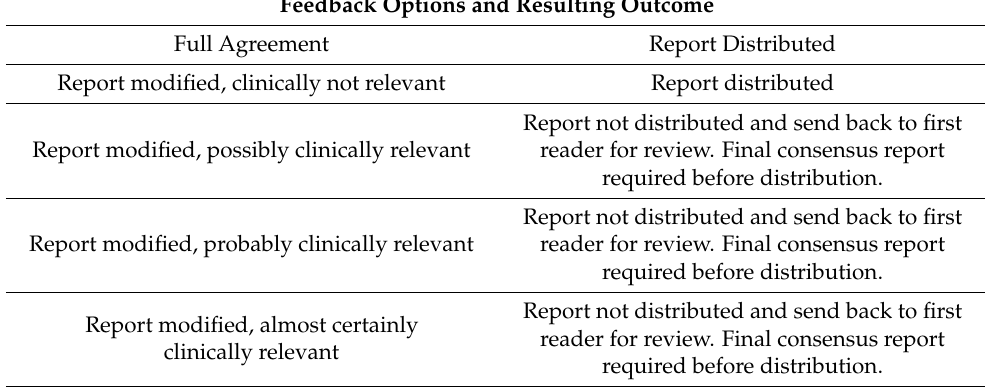
Table 1. Feedback options during second